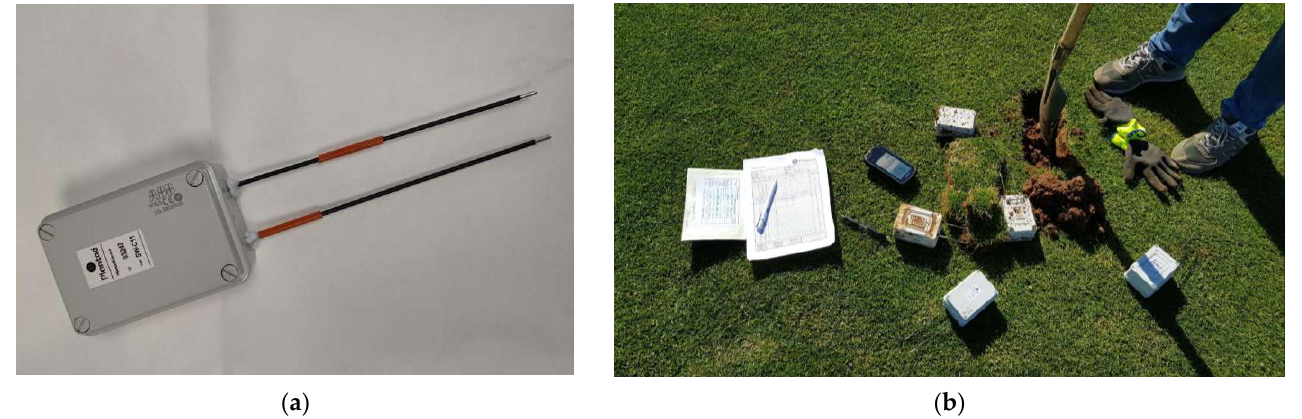
Figure 2. Details of the used sensors ( a ) the sensor, ( b ) installation of sensor in one of the selected greens.